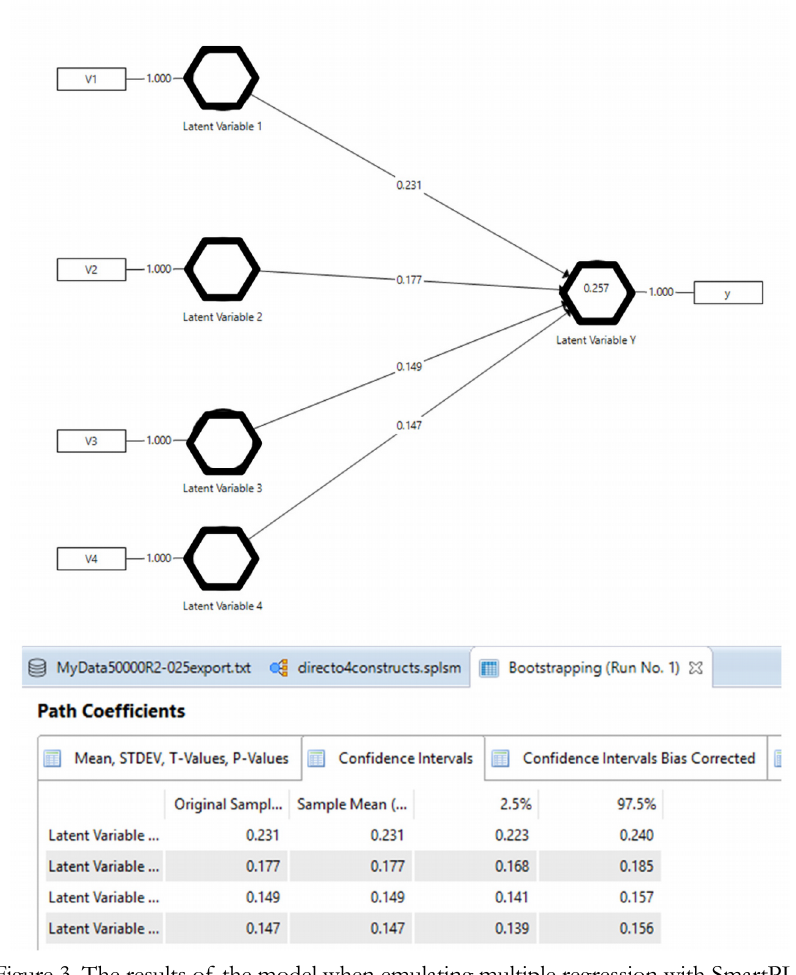
Figure 3. The results of the model when emulating multiple regression with SmartPLS